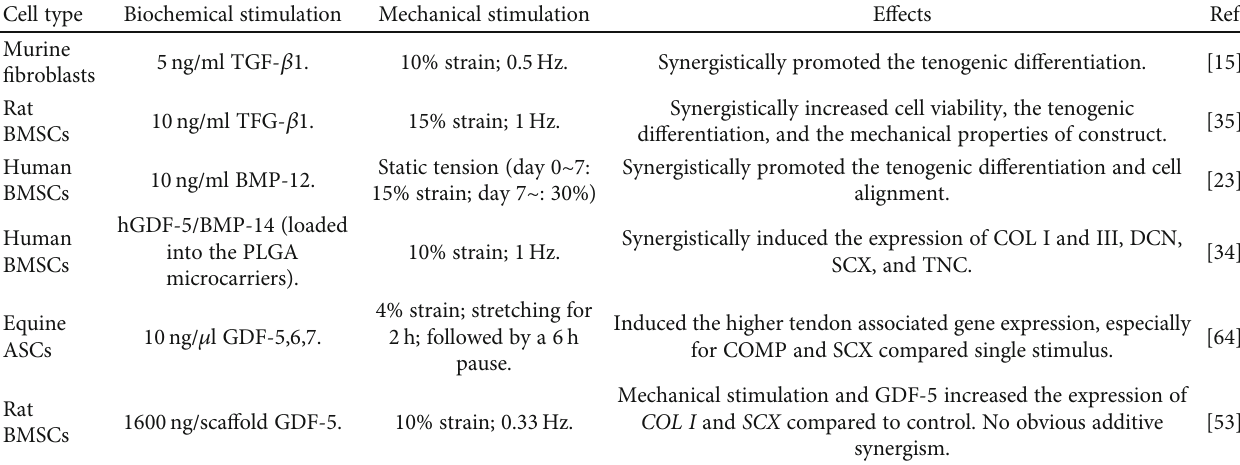
Table 3: Combination of the mechanical and biochemical stimulations in tendon tissue engineering. Cell